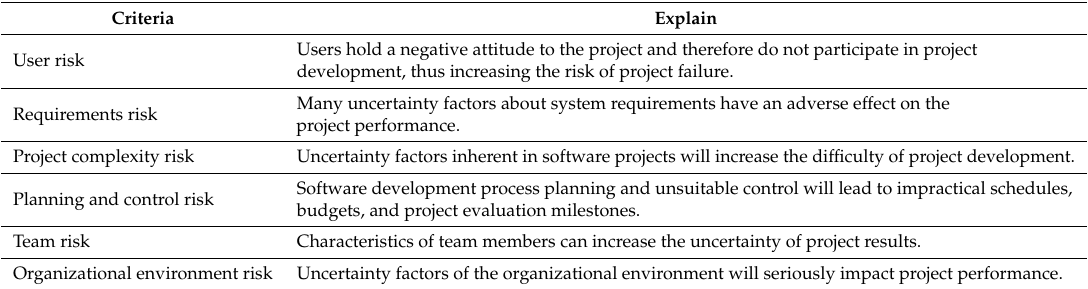
Table 1. Explanation of project risk criteria.